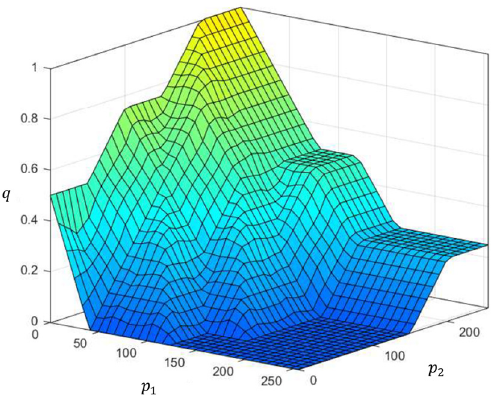
Figure 16. The input to output mapping surface of the proposed FIS to derive the degree to which a pixel belongs to the crack class.